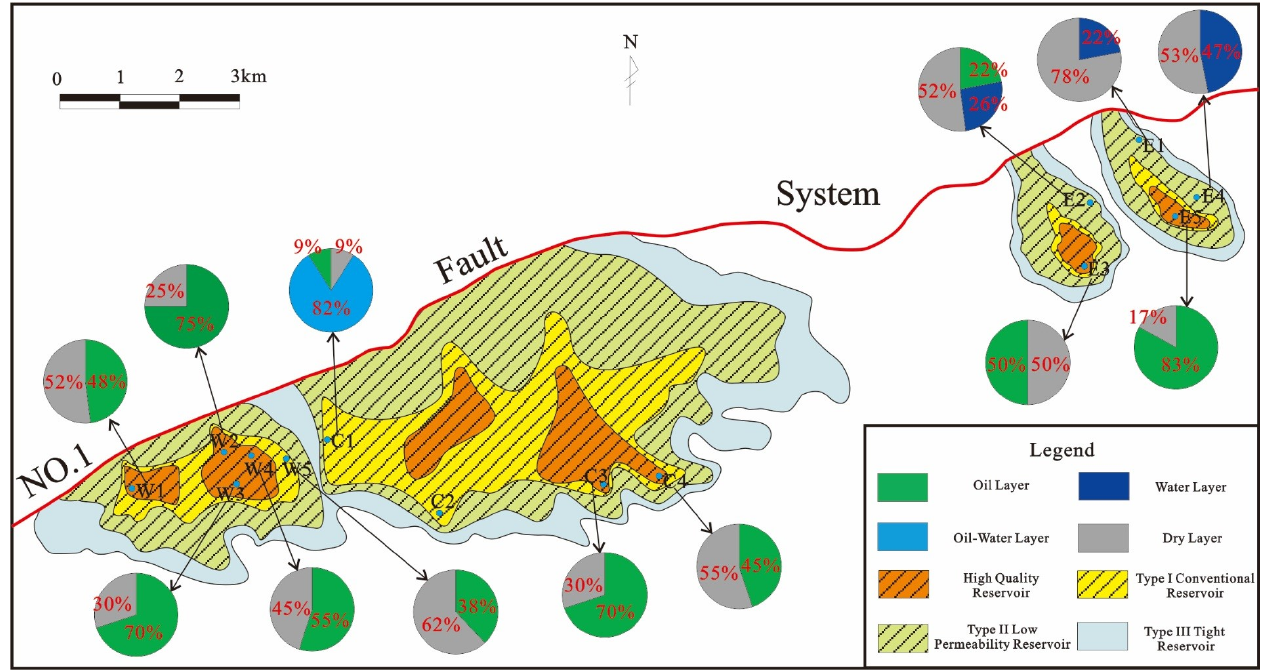
Figure 15. The high-quality reservoirs in the northern steep-slope zone of the Weixinan Sag.